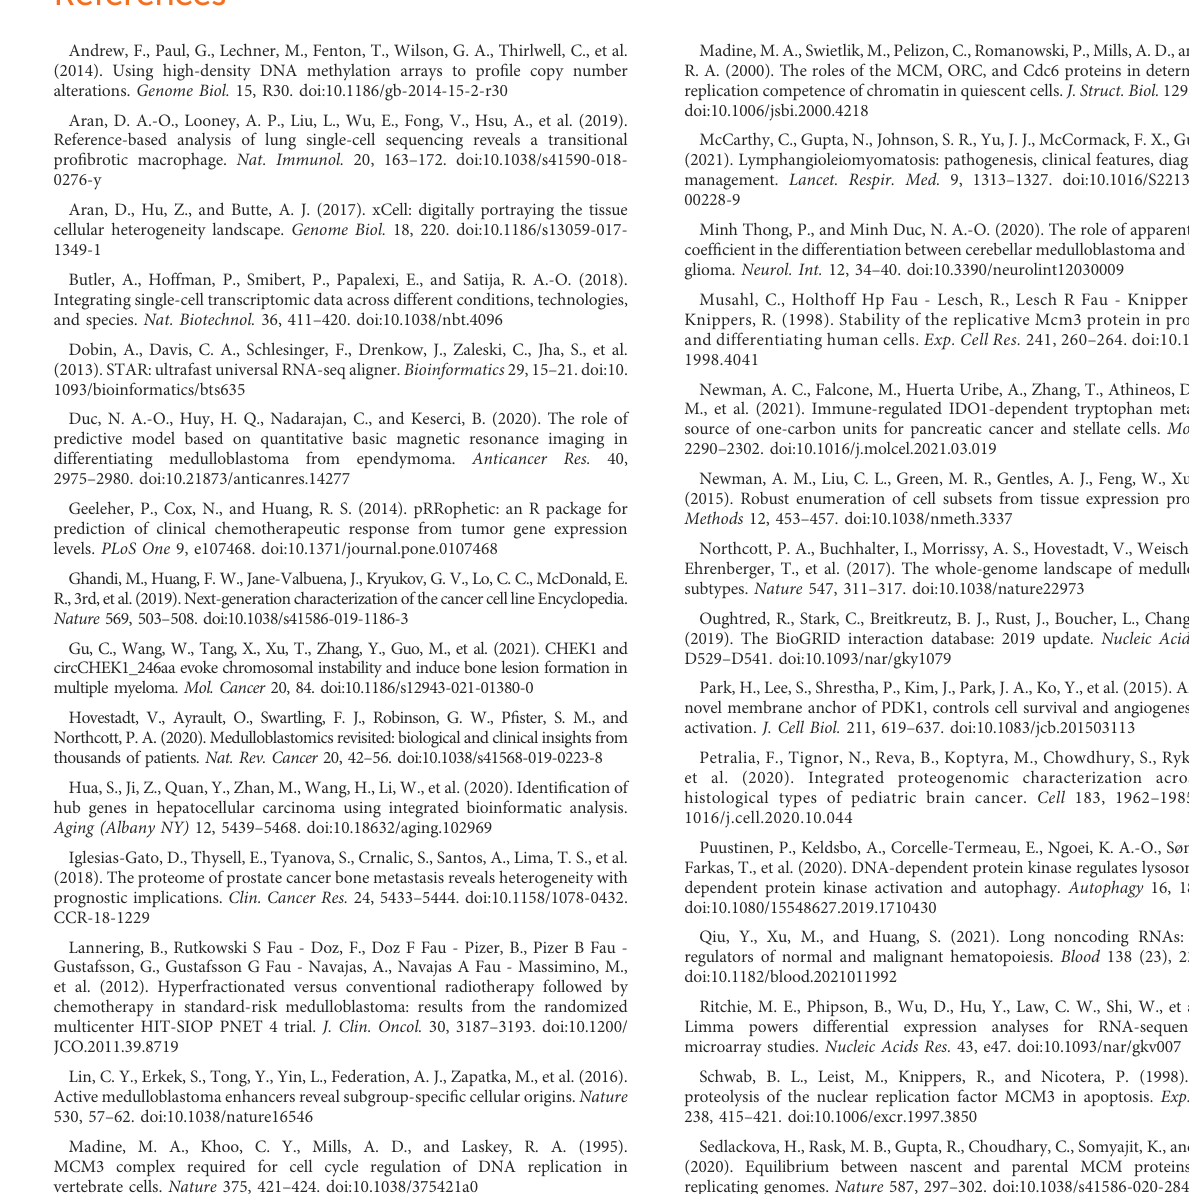
SUPPLEMENTARY FIGURE S1 DysregulationofMCM3inmostcancerscomparedtocorrespondingnormal tissues . MCM3 upregulation in the tumor group compared to adult normal samples from GSE42656 (B) . MCM3 upregulation in the tumor group comparedtofetalnormalsamplesfromGSE42656 (C) .Theadultnormaland medulloblastoma samples from GSE42656 clustered according to the expression of 255-DEGs (D) . The fetal normal and medulloblastoma samples from GSE42656 clustered respectively according to the expression of 255-DEGs (E) . The core position of MCM3 among DEG interactions (F) . Ranking of MCM3 within the top three hub genes (G) . SUPPLEMENTARY FIGURE S2 Estimation of tumor-in fi ltrating cells via three algorithms, including ESTIMATE, CIBERSORT, and XCELL, showing differential in fi ltration of immunecells,includingcytotoxiclymphocytes, fi broblasts,CD4Tcells, macrophages, etc.